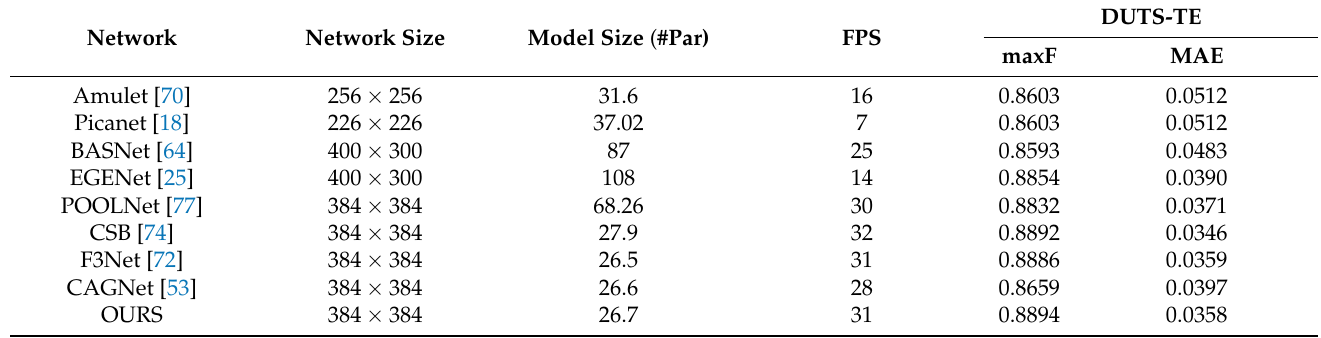
Table 6. Ablation comparison with several known state-of-the-art methods in terms of the number of parameters in millions (#Par), average speed time (FPS), maxF, and MAE on the DUT-OMRON